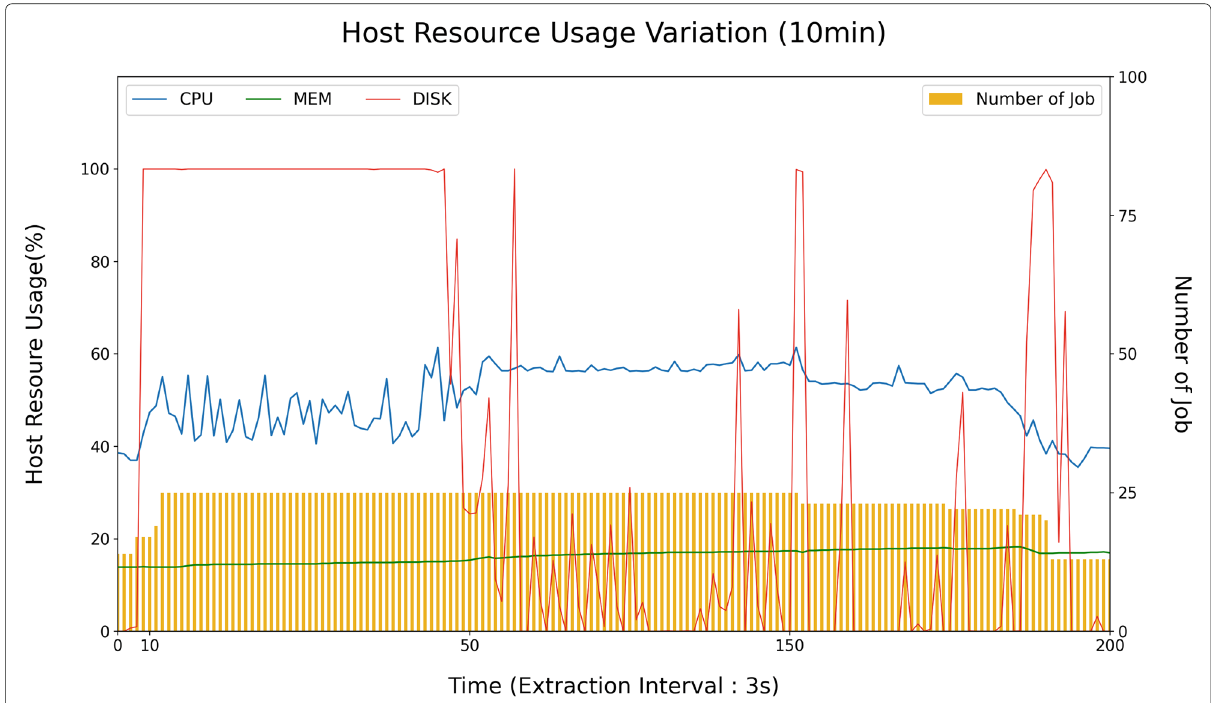
Fig. 3 Host Usage Variation over 10